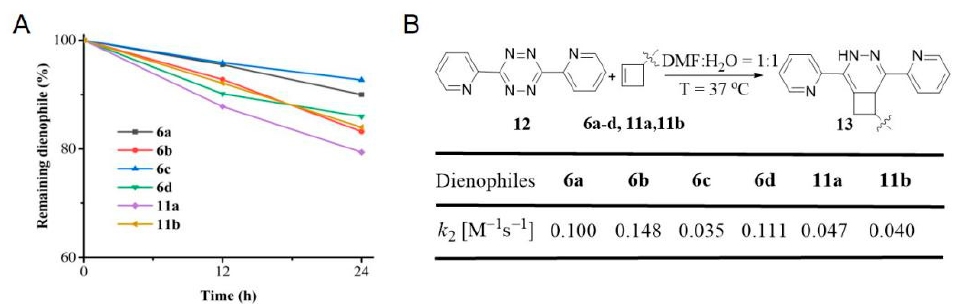
Figure 1. ( A ) Stability of the cyclobutene derivatives 6a – 6d , 11a , and 11b during incubation in N,N -dimethylformamide/phosphate-buffered saline (1:1) at 37 ◦ C for 24 h. Absorption was monitored using high-performance liquid chromatography. ( B ) Kinetics of the inverse electron demand Diels–Alder (IEDDA) reactions between tetrazine 12 and 6a – 6d , 11a , and 11b . Conditions: 0.5 mM tetrazine, 5 mM dienophile, DMF/H 2 O (1:1), 37 ◦ C.